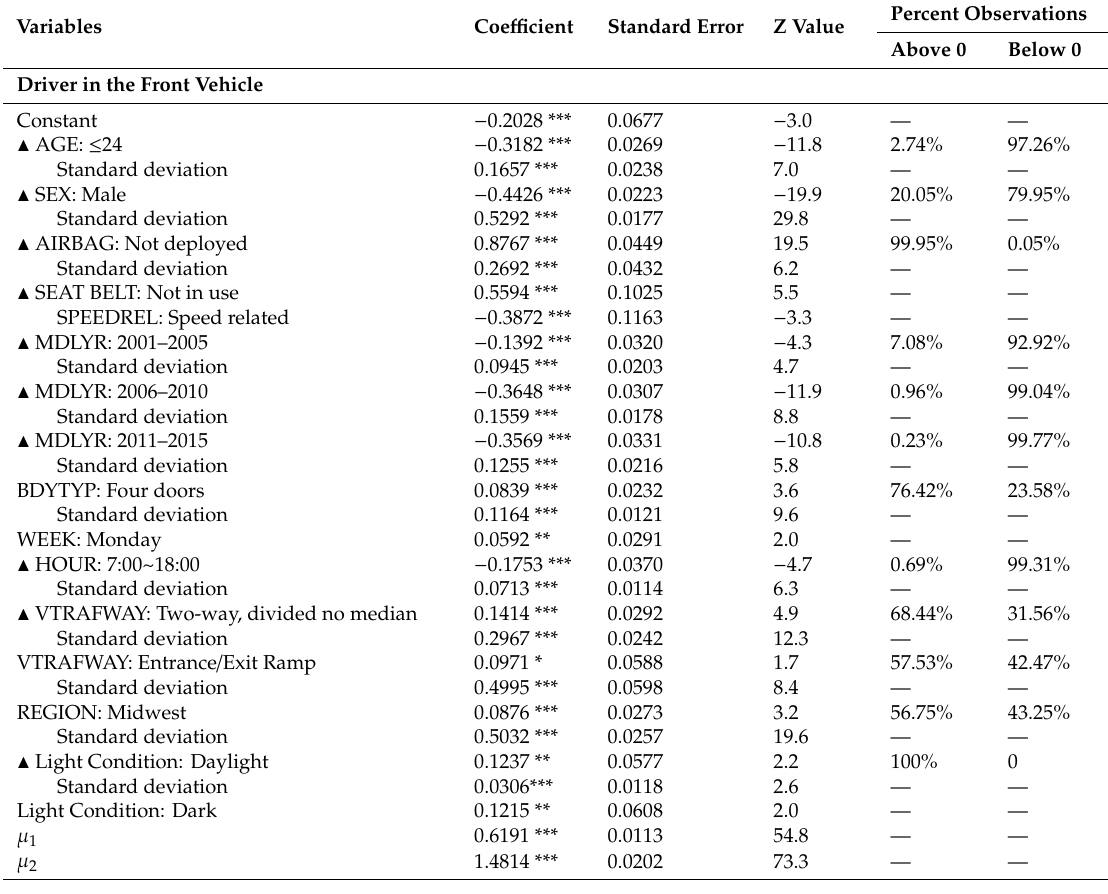
Table 3. Results of random parameter bivariate ordered probit